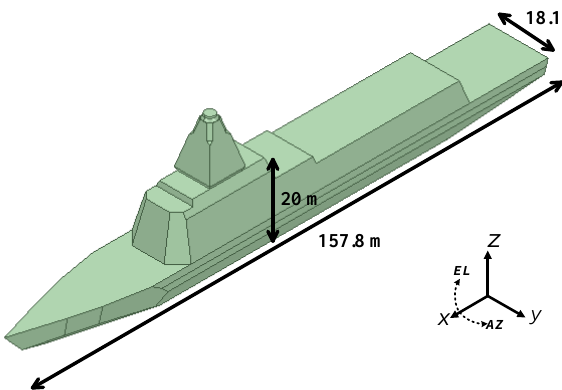
Figure 9. Geometry and dimension of the naval vessel.